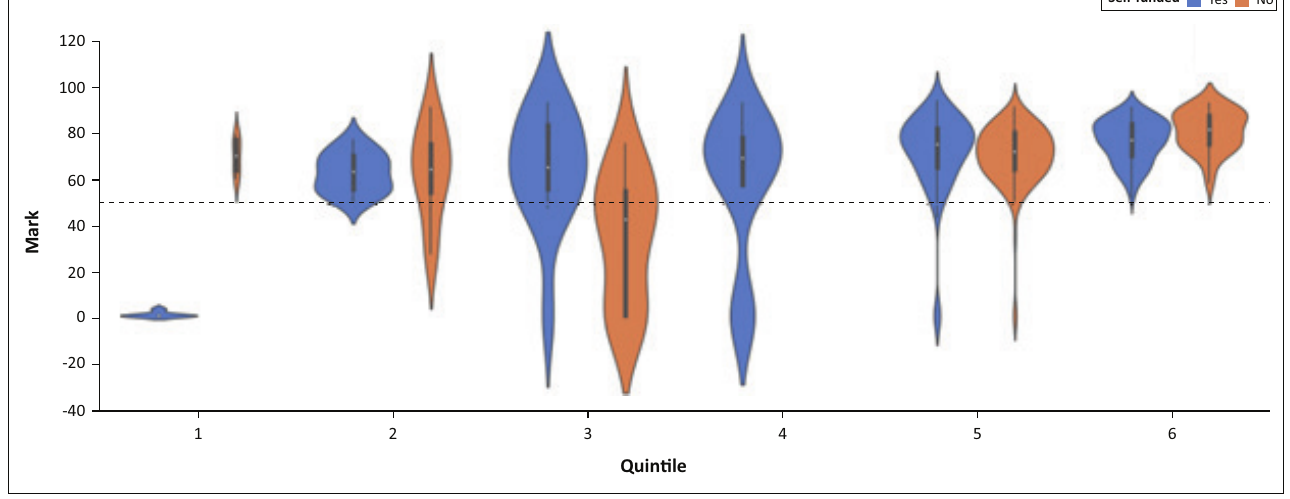
FIGURE 9: Relationship between self-funded students, the quintile and